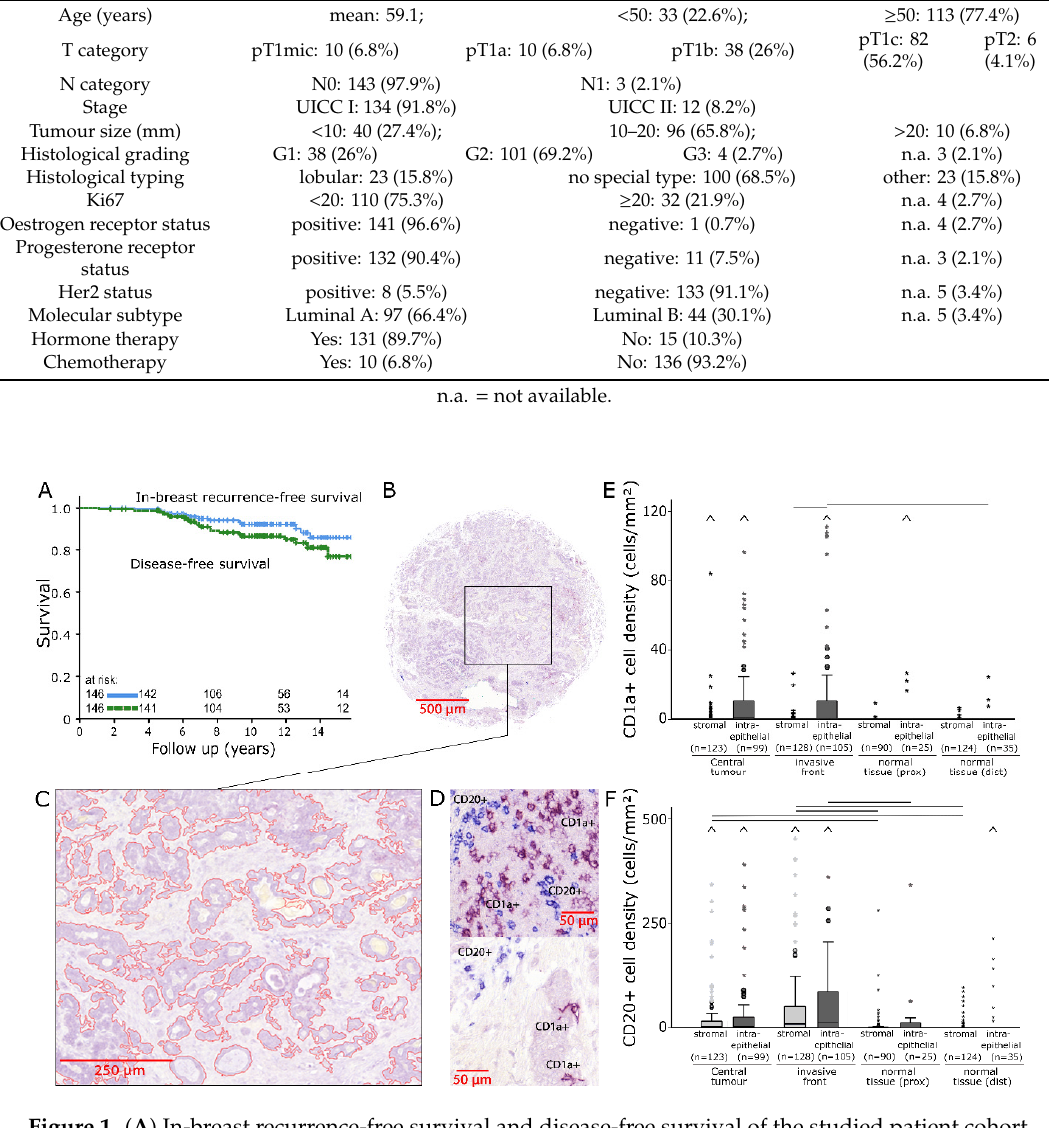
Figure 1. ( A ) In-breast recurrence-free survival and disease-free survival of the studied patient cohort analysed with the Kaplan–Meier method and log-rank test. ( B ) Image of a representative breast cancer tissue microarray core double-stained for CD1a/CD20 (200 × magnification). ( C ) Intraepithelial tumour compartment marked with image analysis software. ( D ) Representative examples of CD1a+ (violet) and CD20+ (blue) tumour-infiltrating inflammatory cells (TIICs). ( E , F ) Stromal and intraepithelial cell density distributions of CD1a+ ( E ) and CD20+ TIICs ( F ) in samples from four different locations. The central line represents median values, while the box is indicative of the interquartile range (IQR). Whiskers represent 1.5× IQR or minimum/maximum. Outliers are indicated by points (up to 3 × IQR) or asterisks (>3 IQR). Outliers not visible in this diagram are depicted as a caret. Black bars signify p < 0.05 in Student’s t test.